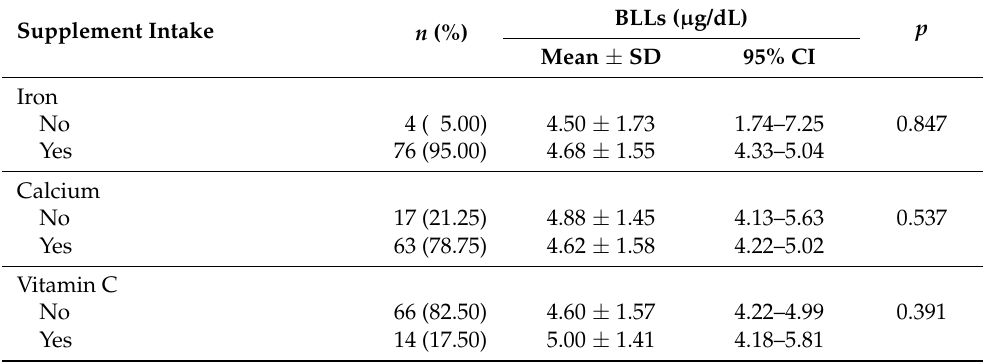
Table 3. The supplement intake of pregnant women (in the past month) and mean, 95% CI for BLLs ( n =